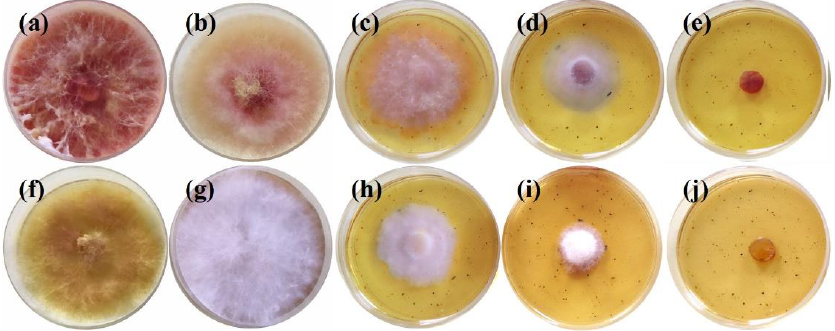
Figure 1. Example of sensitivity test. Radial growth of mycelium for treatments without AgNPs ( top ) and with AgNPs ( bottom ): ( a , f ) control (no gallic acid); ( b , g ) 62.5 µg·mL −1 ; ( c , h ) 125 µg·mL −1 ; ( d , i ) 250 µg·mL −1 ; and ( e , j ) 500 µg·mL −1 of gallic acid-based composite in DES dispersion medium.